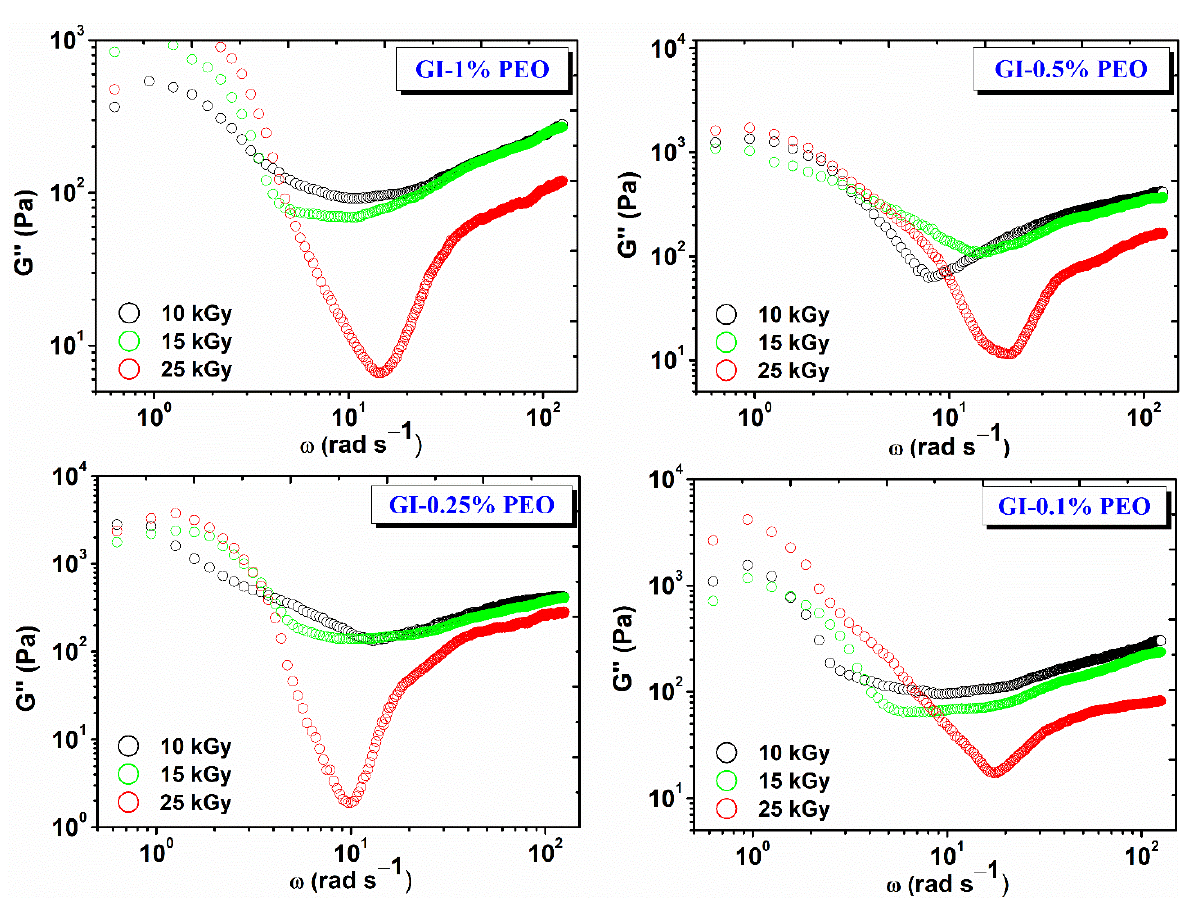
Figure 4. Variation of G ″ depending on the angular frequency ( ω ) and the absorbed dose.